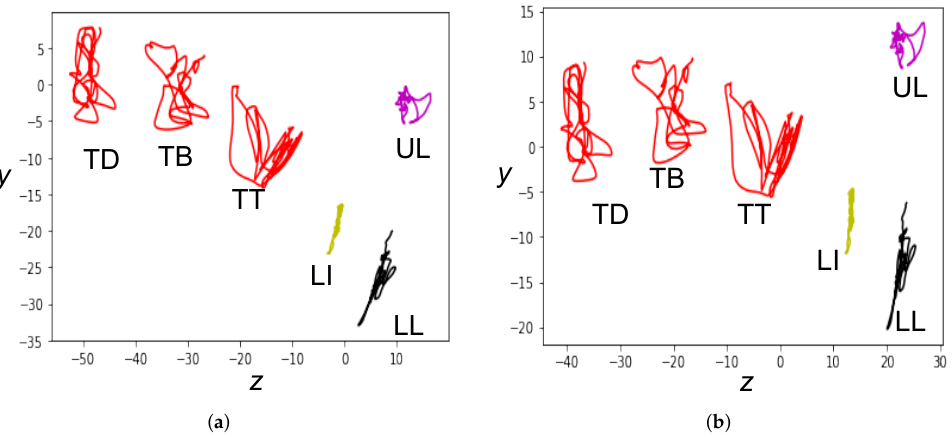
Figure 3. Example of shapes (motion path of the articulators) before and after Procrustes matching for producing “the birch canoe slid on the smooth planks”. In this coordinate system, y is vertical and z is anterior-posterior. ( a ) Before Procrustes matching. ( b ) After Procrustes